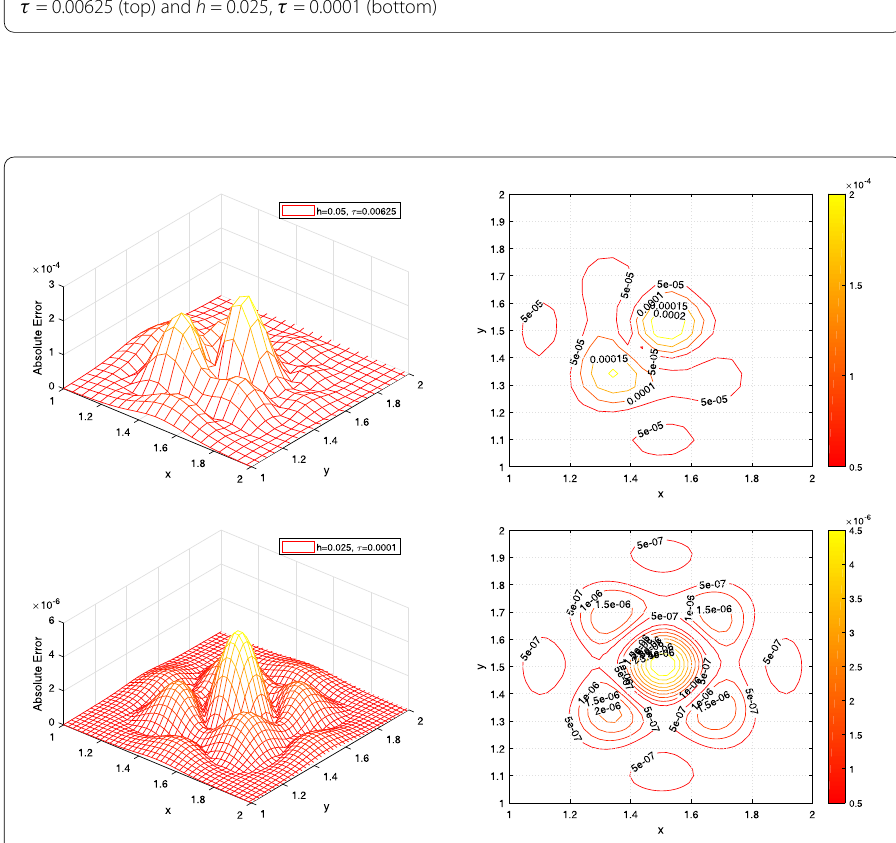
Figure 3 Absolute error and its contour by the DHOC-ADI scheme using h x = h y = 0.05, τ = 0.00625 (top) and h x = h y = 0.025, τ = 0.0001